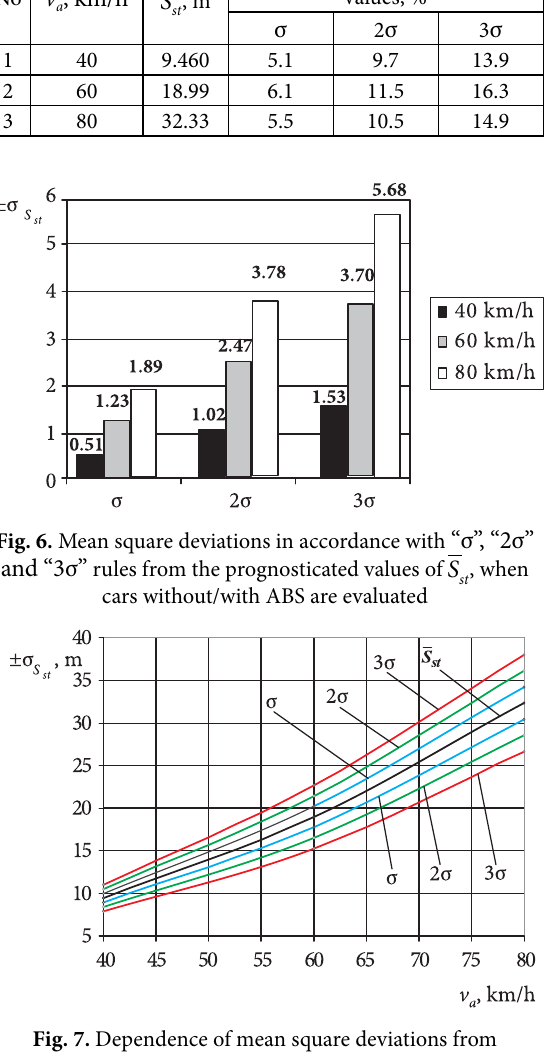
Fig. 7. Dependence of mean square deviations from S values on the car speed, when cars prognosticated st without/with ABS are